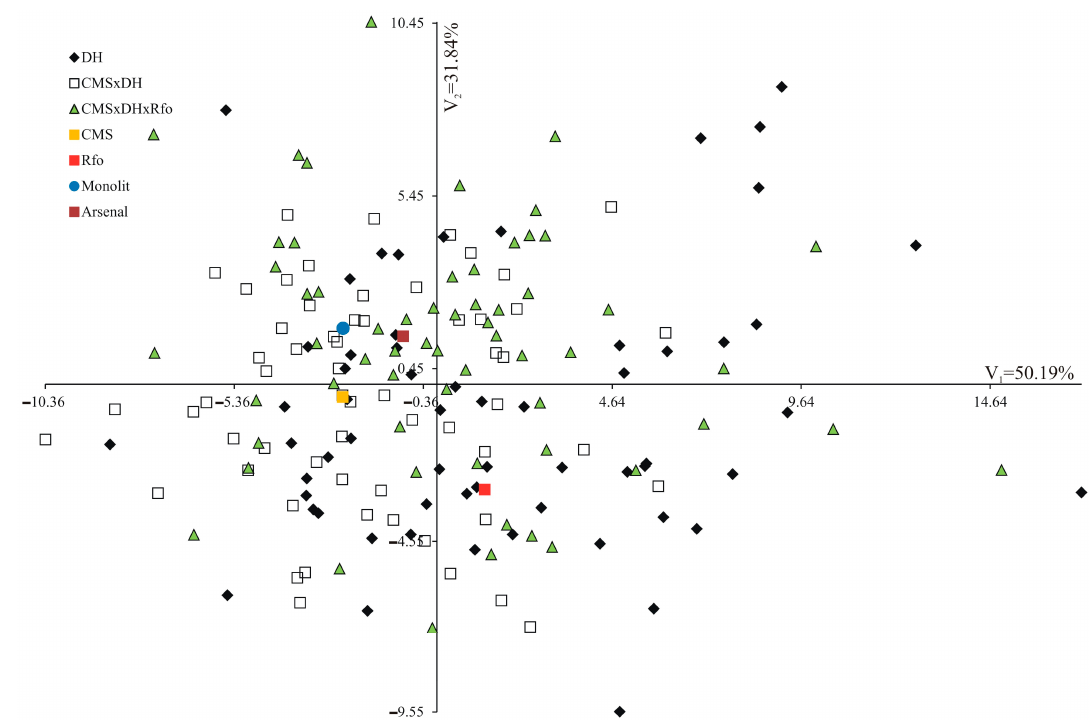
Figure 2. Distribution of 182 genotypes of winter oilseed rape ( Brassica napus L.) in the space of the first two canonical variates in 2016.